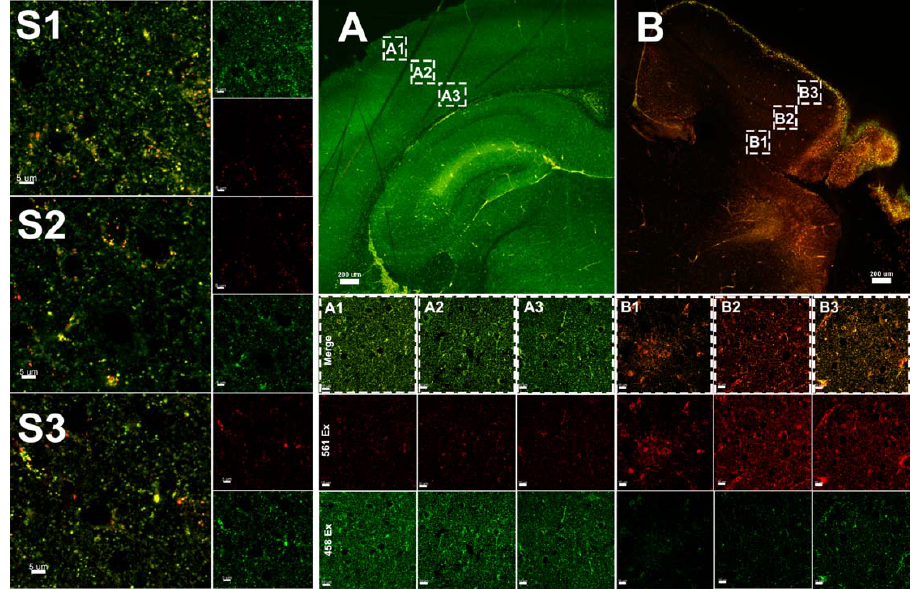
Figure 7. Assessment of mitophagy 7 days after HI in the brain tissue of mt-Keima mice by super- resolution microscopy; (( A ), A1–A3) uninjured hemisphere; (( B ), B1–B3) injured hemisphere; serial sections are visualized at 100 μ m intervals (indicated in dashed rectangles) of both hemispheres.